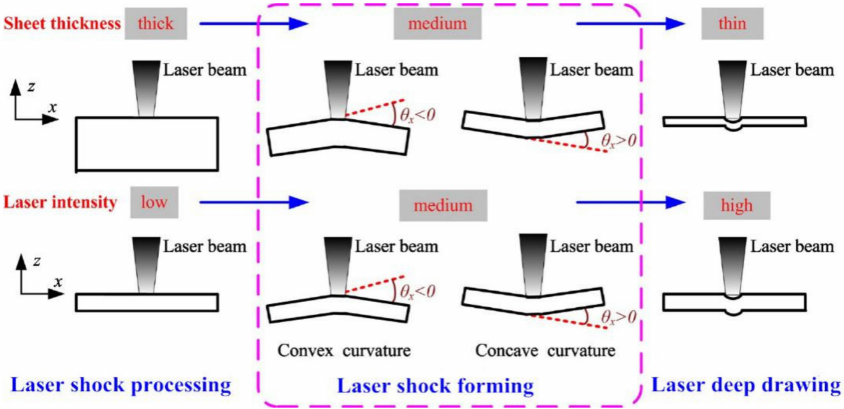
Figure 8. The e ff ect of sheet thickness and laser intensity on the coupling of two mechanism of LPF